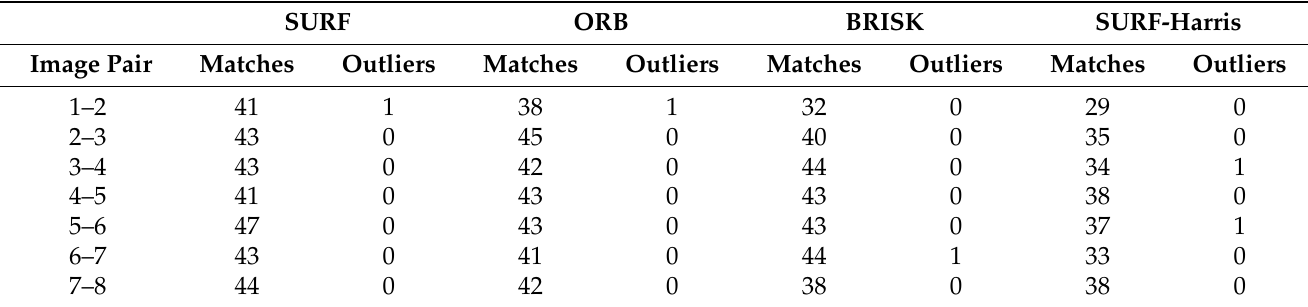
Table 5. Number of matches performed and corresponding number of outliers for dataset 1. SURF